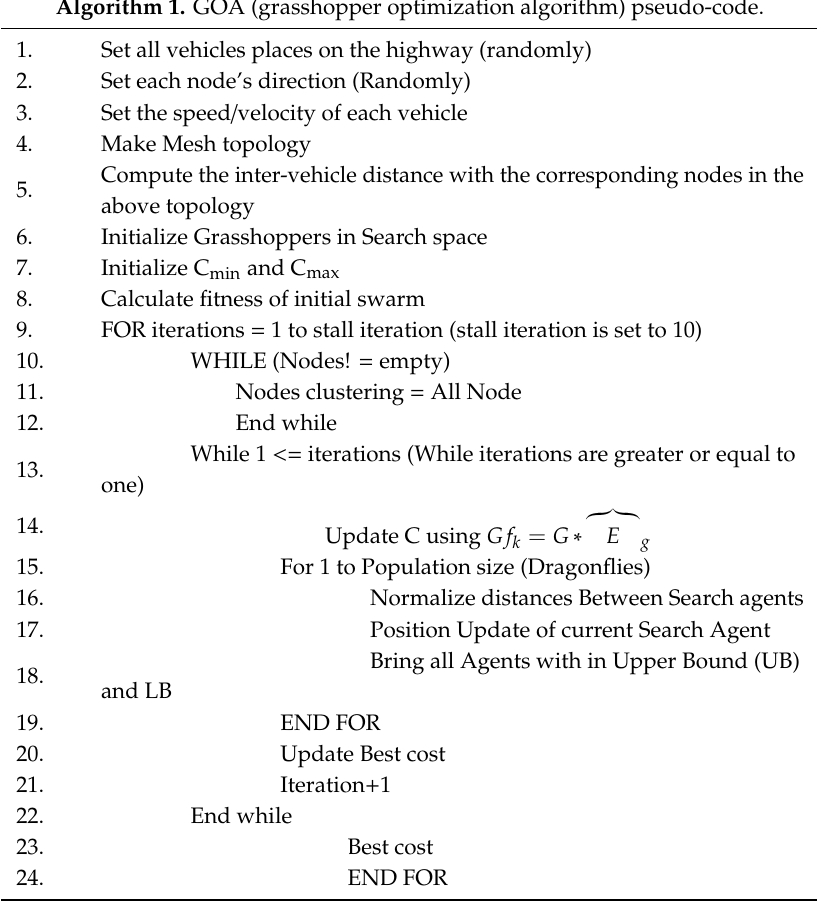
Algorithm 1. GOA (grasshopper optimization algorithm)